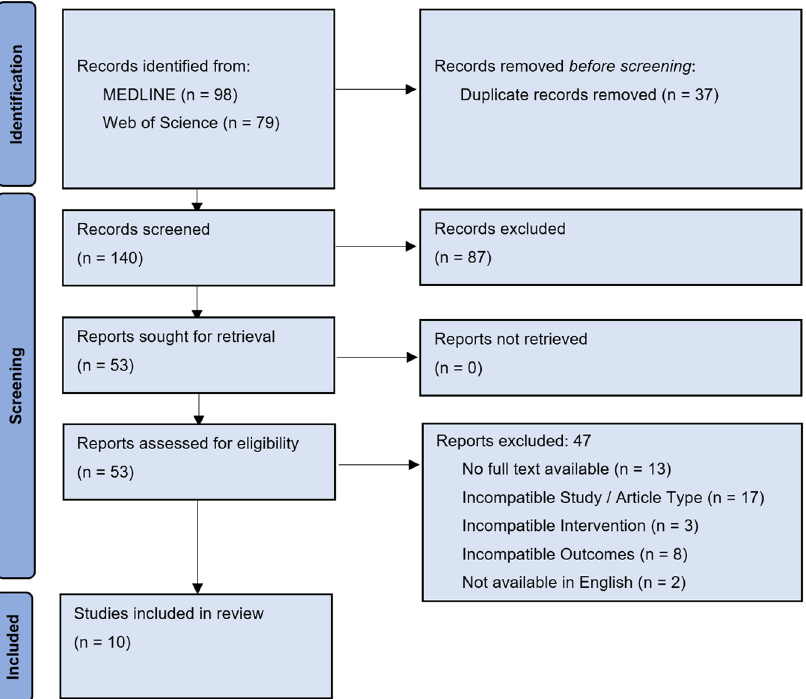
Fig. 1 Preferred reporting items for Systematic Reviews and Meta-Analysis (PRISMA) fl ow diagram showing the process of study selection for this systematic review of symptom checker diagnostic and triage